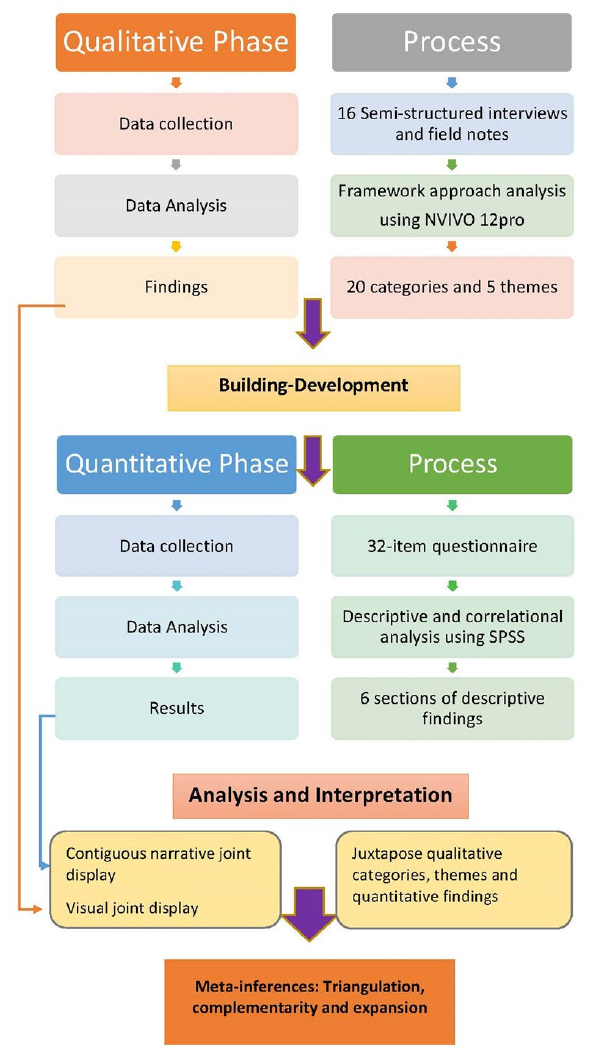
Figure 1. Overview of the exploratory sequential design. Note: in the framework approach, during the analysis process, codes are grouped into clusters around similar and interrelated ideas, called categories.